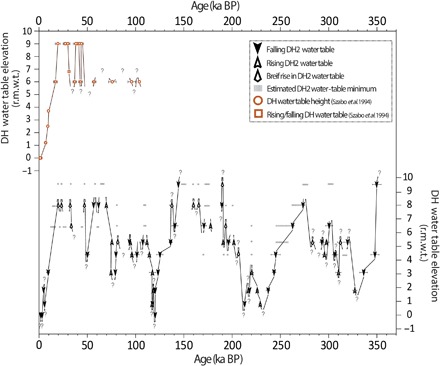
DH caves water table records.DH record [orange; (11)] and DH2 record (black; this study) plotted r.m.w.t. with 2σ uncertainties. Modern water table elevations are identical in both caves (see main text). Arrows represent inferred water table direction. Dashed horizontal bars represent estimated water table minimums, as determined by the presence of thin mammillary calcite layers (see main text). Question marks denote uncertainties in water table minima/maxima. BP, before present (1950 A.D.).